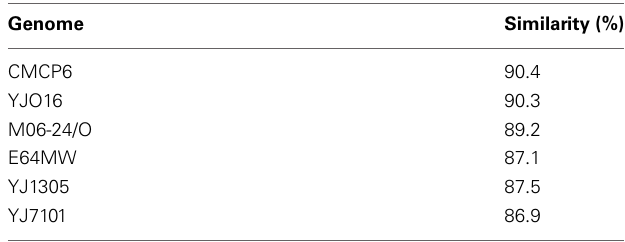
Table 2 | Genome similarity as revealed by the whole-genome comparisons between biotype 3 strain VVyb1(BT3) and each of the six listed biotype 1